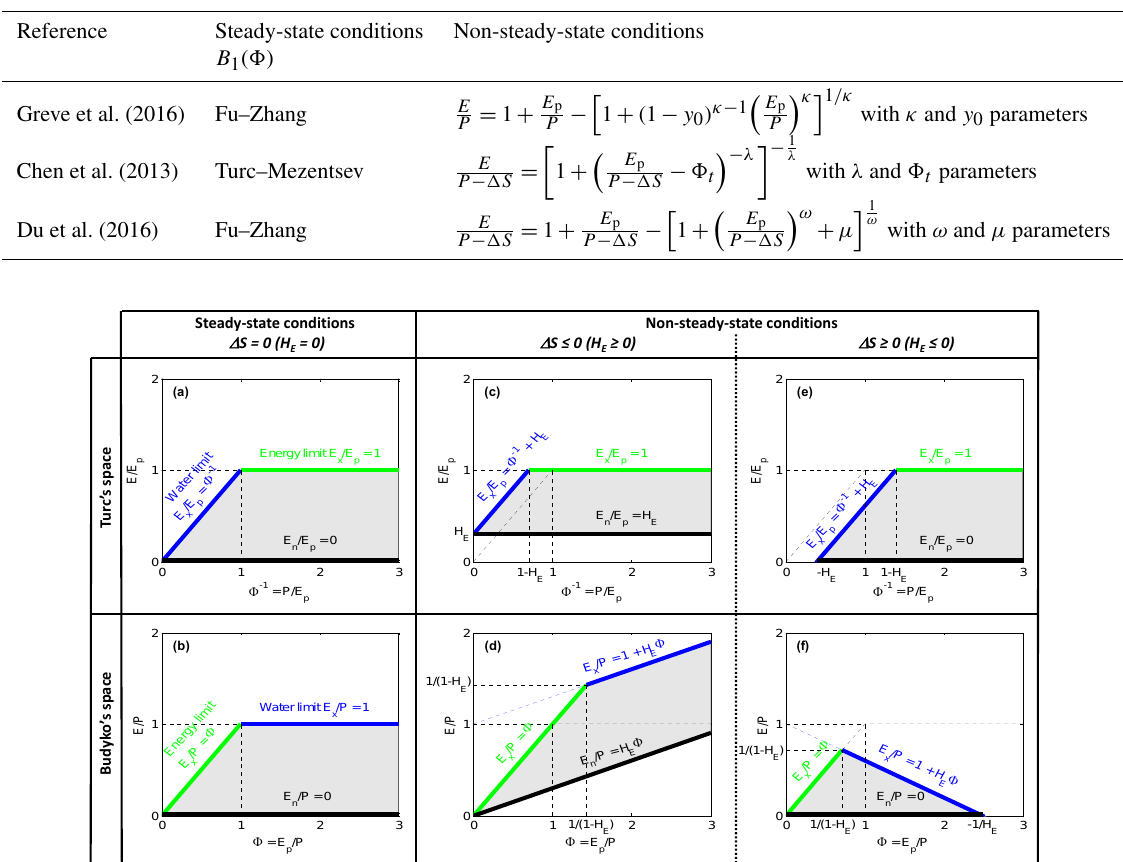
Table 2. Different expressions for the Budyko curves under non-steady-state conditions. Reference Steady-state conditions